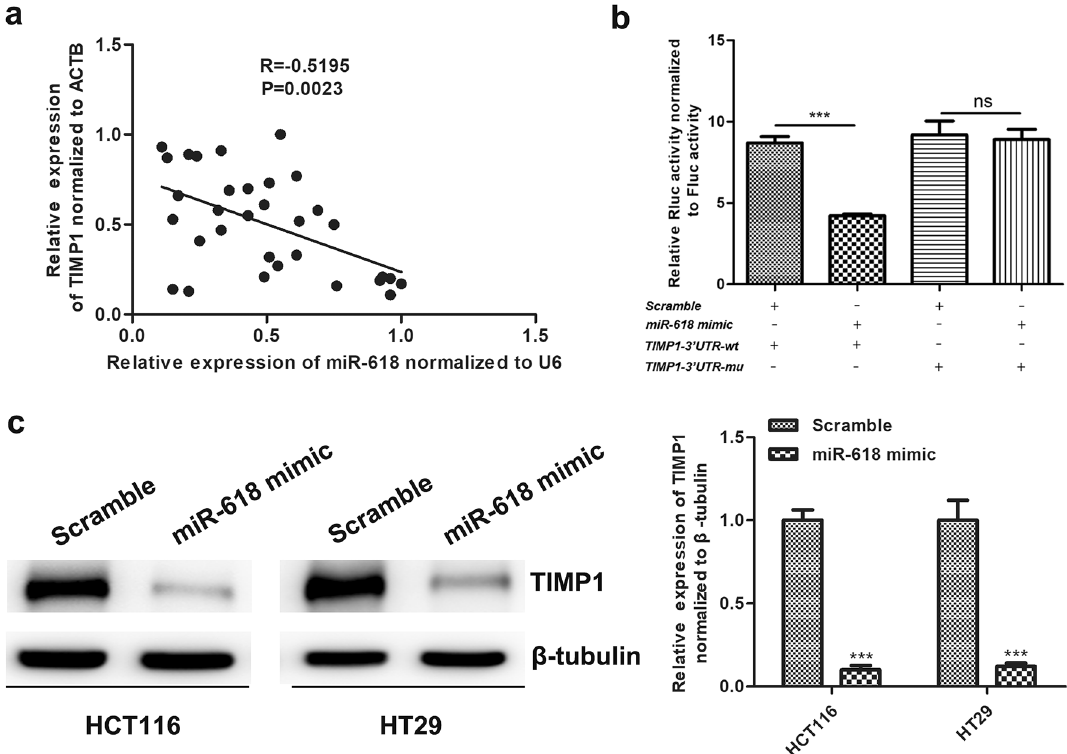
Figure 4. miR-618 directly targets TIMP1 expression in colorectal cancer. ( a ) The expression correlation analysis between miR-618 and TIMP1 in gastric colorectal cancer tissues (n = 32). R = − 0.5195, P = 0.0023. ( b ) Luciferase reporter assay of HEK293T cells which were cotransfected with wild-type or mutant psiCHECK2- TIMP1-3’UTR and miR-618 mimics or Scramble. ns = no significance, *** P < 0.001 (t-test). ( c ) Western blot analysis of the TIMP1 in HCT116 and HT29 cells transfected with miR-618 mimic or Scramble (left), and the followed grayscale value analysis is shown (right). Data are reported as means ± SD of three independent experiments. ** P < 0.01, *** P < 0.001